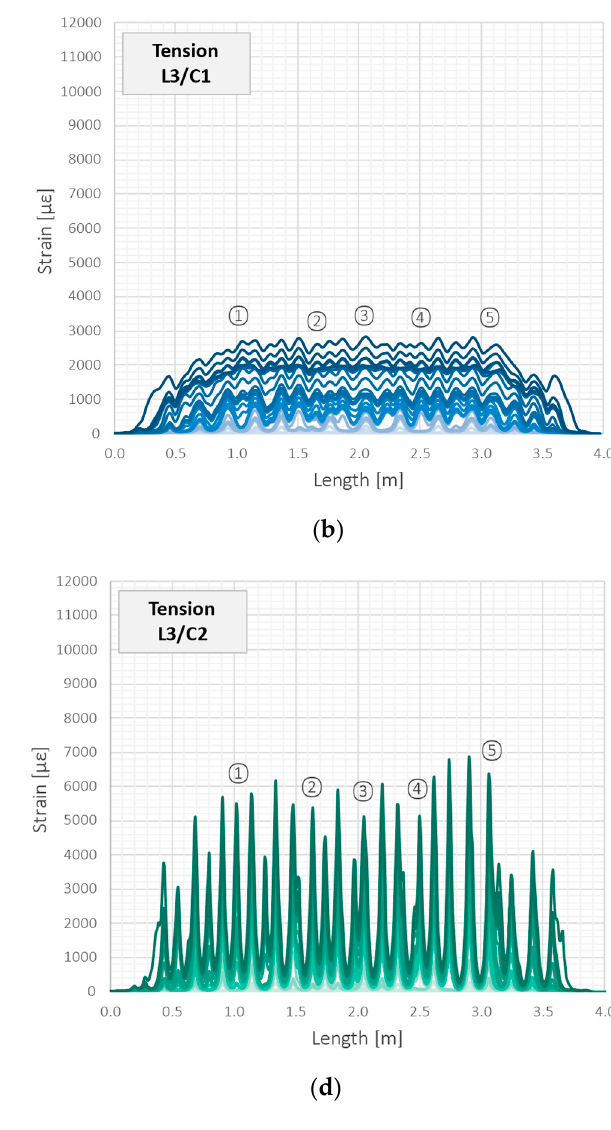
Figure 21. Beam L3/tension zone: strain profiles over entire length registered by the following DFOS tools: ( a ) M1; ( b ) C1; ( c ) M2; ( d ) C2.